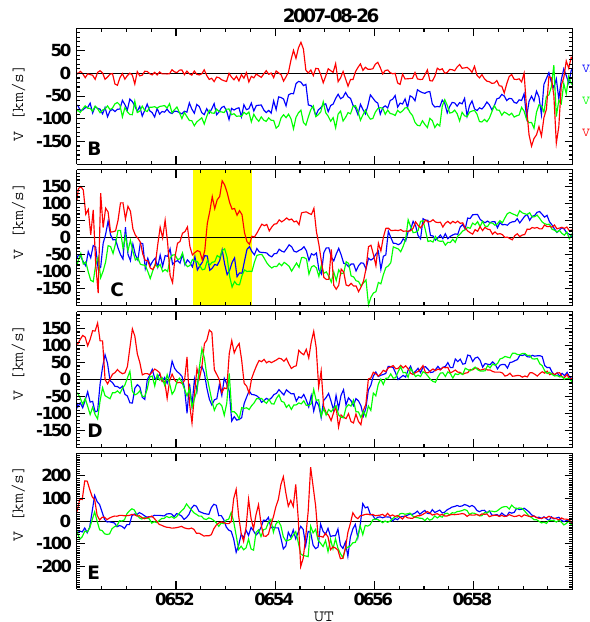
Fig. 13. Velocity profiles of THB, THC, THD and THE during event 4. The colour of velocity components are: v X – blue; v Y – green; v Z – red. The yellow area marks an interval of the discussed change of v Z